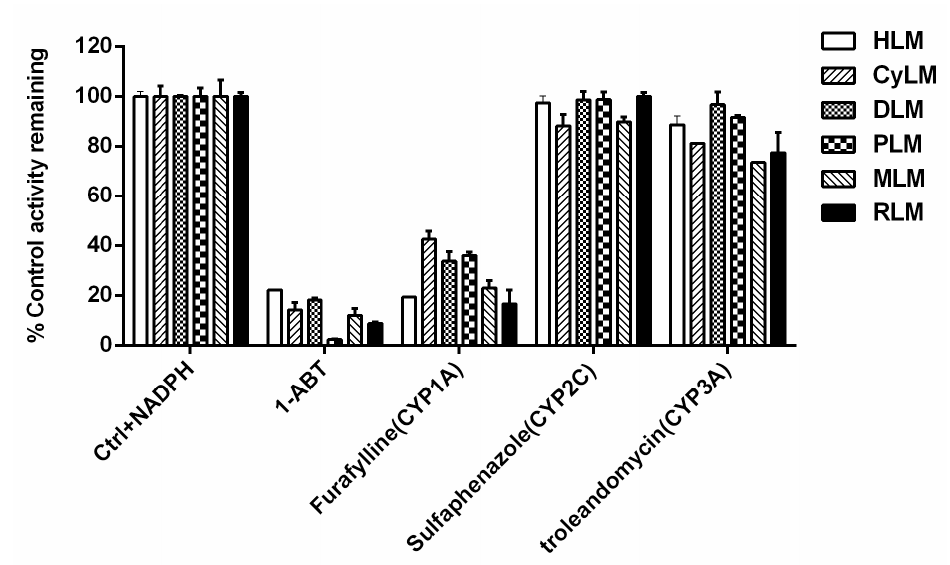
Figure 3. The inhibitory e ff ects of chemical inhibitors of cytochrome P450s (CYPs) on the formation of NCMN in liver microsomes from di ff erent species. N.D. means not detected.